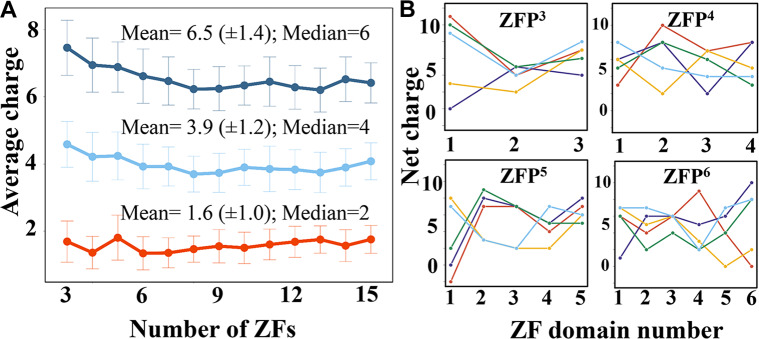
Electrostatic properties of the C2H2-type zinc-finger proteins (ZFPs).(A) The average number of positive (dark and light blue) and negative (red) charges are shown for human C2H2-type tandem ZFPs of different lengths (comprised of 3 (ZFP3) to 15 (ZFP15) zinc finger (ZF) domains. The His residue may be present in its positively charged (deep blue line) or neutral (light blue line) form. (B) The number of net charges on each zinc finger is shown for ZFP3–ZFP6. Each panel presents the analysis of five representative ZFPs (shown in five different colours) of the same length (as indicated by the superscript in the panel title). The analysis shows that the net charge of individual zinc finger domains within a protein can vary significantly.